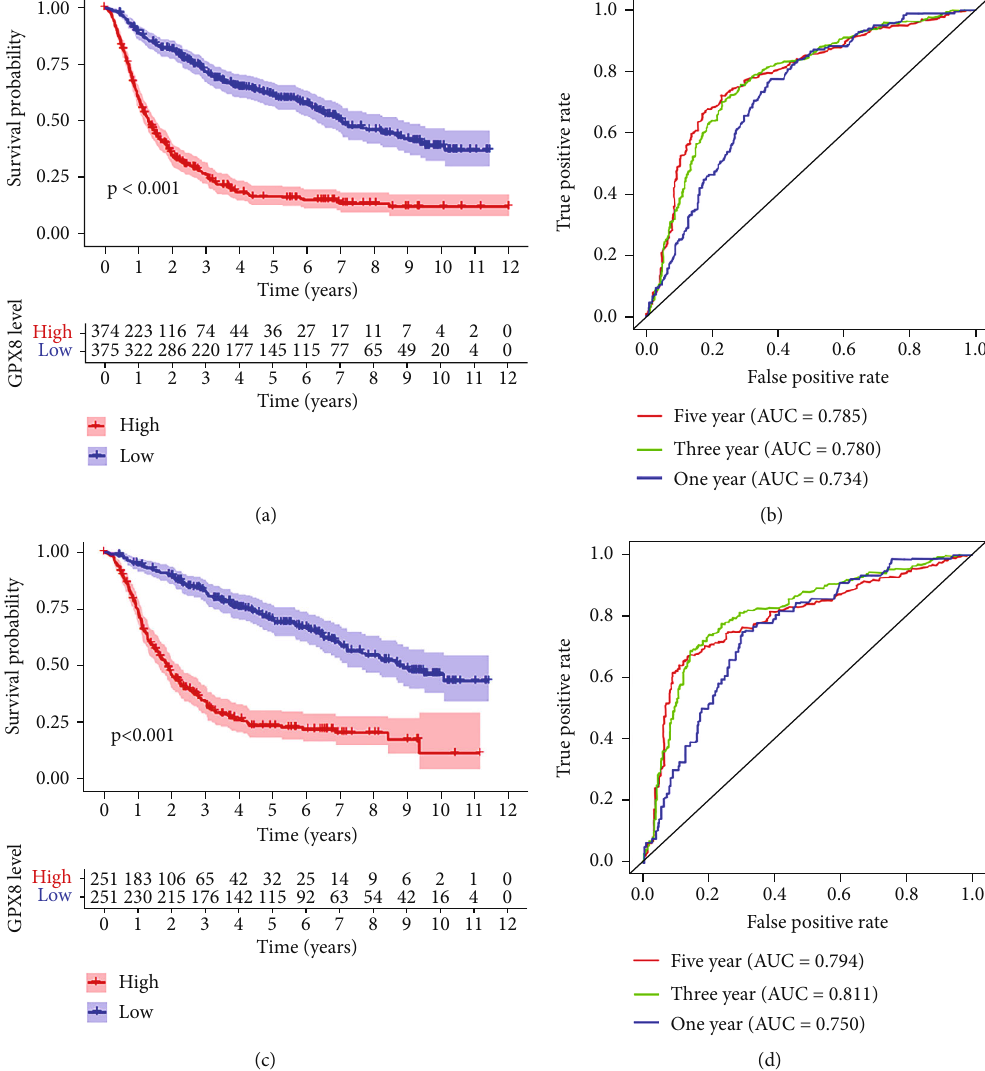
Figure 2: The survival curves and the ROC curves. (a) High GPX8 expression in all types of gliomas was associated with shorter overall survival. High : low = 374 : 375 ; HR 1.4-1.622; P < 0 : 001 . (b) ROC curves showed that GPX8 as a prognostic marker was valuable for all types of gliomas. (c) High GPX8 expression in primary gliomas was associated with shorter overall survival. High : low = 251 : 251 ; HR 1.6-1.847; P < 0 : 001 . (d) ROC curves showed that GPX8 had a medium diagnostic accuracy in primary gliomas.